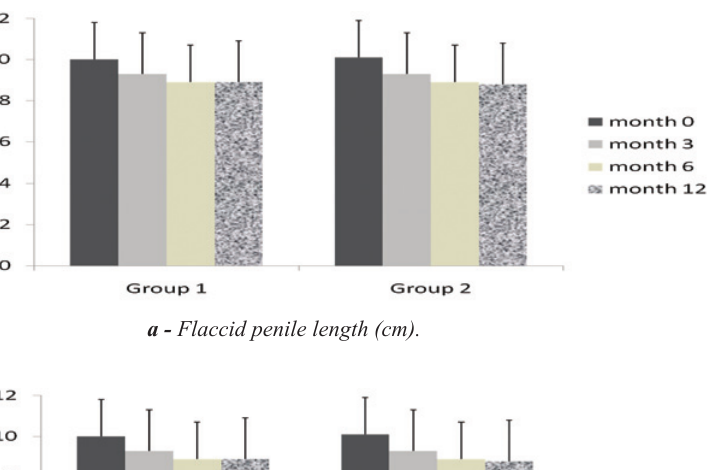
Figure 2 - The means and standard deviations (SD) of penile measurements preoperatively and at months 3, 6 and 12 postoperatively for both